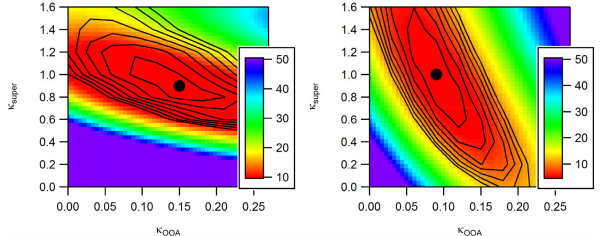
Figure 5. Visualization of the optimization procedure for the super- micron and OOA hygroscopicities at T0 (left) and T1 (right). The χ 2 value is shown as a false color image where the redder colors are lower in value. The global minimum is indicated by the dot and contours are included added to accentuate the shape of the